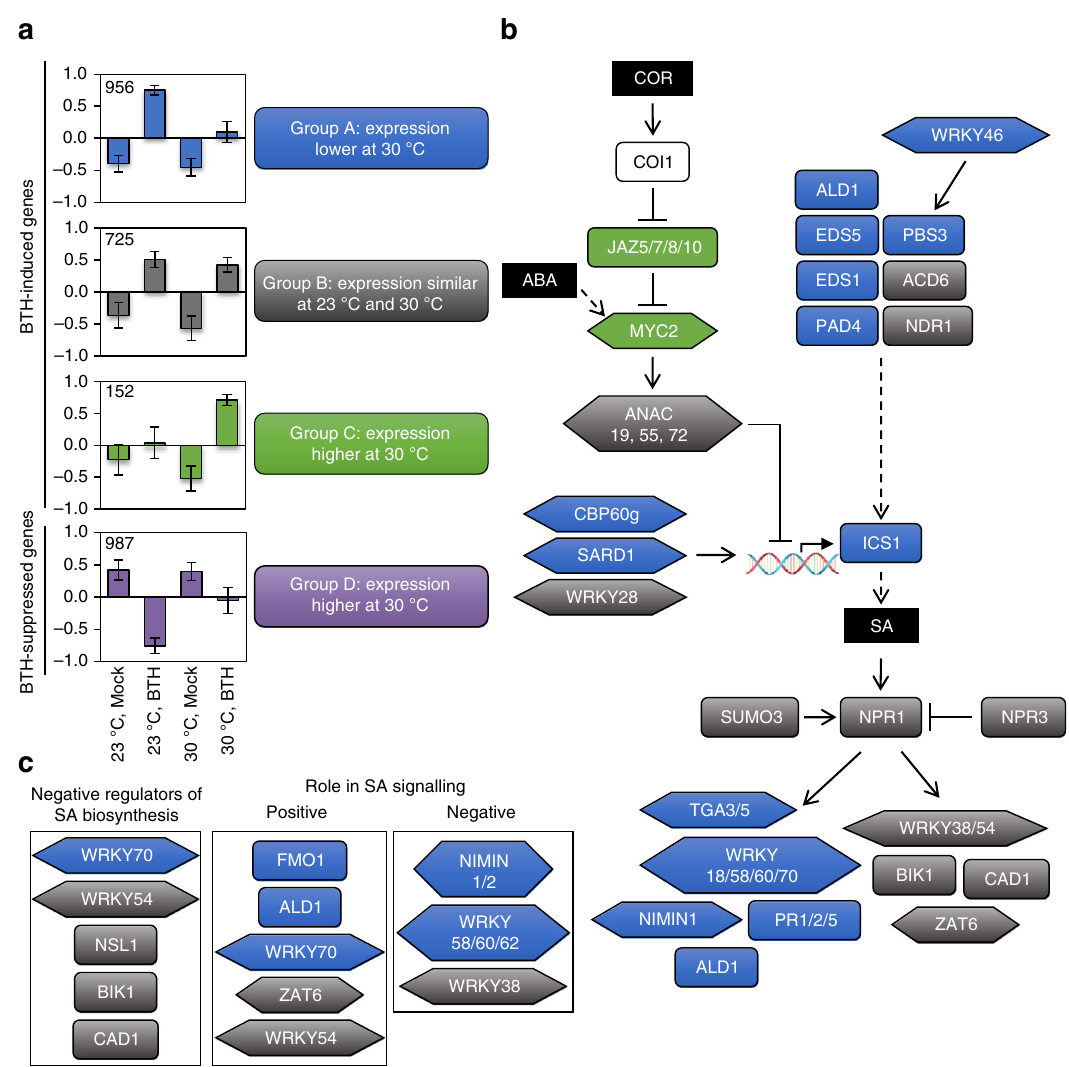
Fig. 5 Global transcriptome analysis reveals a temperature-sensitive bifurcation in the SA signalling network. a RNA-seq gene expression pro fi les. Tissue was harvested for RNA extraction and sequencing 24 h after spraying plants with mock or BTH solutions. Differentially expressed genes (DEGs) and BTH- induced (groups A – C) and BTH-suppressed (group D) genes were determined as described in the text. Genes were grouped based on a 2-fold change difference in expression between BTH-treated samples at 30 °C vs. 23 °C. Data are represented as the mean ± s.e.m. of the centred, normalized expression values for each sample type (23 °C, Mock; 23 °C, BTH; 30 °C, Mock; 30 °C, BTH) within each group. The number of genes within each group is shown in the upper left corner of each graph. b and c Graphical depiction of genes involved in promotion or suppression of SA biosynthesis via regulation of the ICS1 gene as well as genes involved in the SA signalling pathway. Genes are colour-coded based on the gene group a to which they belong. Genes not differentially regulated within the RNA-seq dataset are depicted using shapes without fi ll. Metabolites are denoted by black boxes with white text; transcription factors are denoted by a hexagon shape. The DNA molecule with bent arrow designates the ICS1 gene promoter. Solid arrows show direct interactions, dotted arrows show indirect interactions and bar-headed lines show inhibitory interactions. References for each gene function depicted is provided in Supplementary Table 4. NPR1-regulated genes in b determined based on microarray study conducted by Wang et al